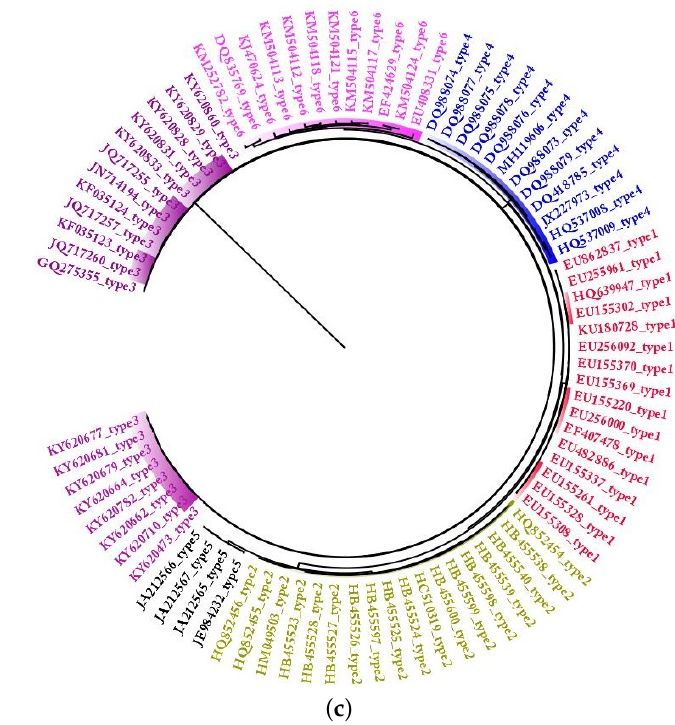
Figure 1. ( a ) The Neighbor-Joining phylogenetic tree of 82 HCV genome sequences based on PCNV method. ( b ) The Neighbor-Joining phylogenetic tree of 82 HCV genome sequences based on FFP method (k = 6). ( c ) The phylogenetic tree of 82 HCV genome sequences based on Bayesian inference method.